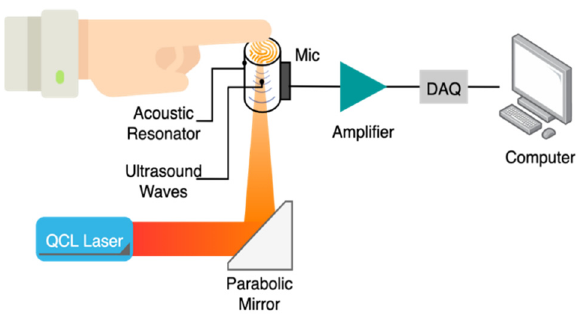
Figure 12. System diagram of photoacoustic spectroscopy for non-invasive glucose measurements. Redrawn from reference [5].